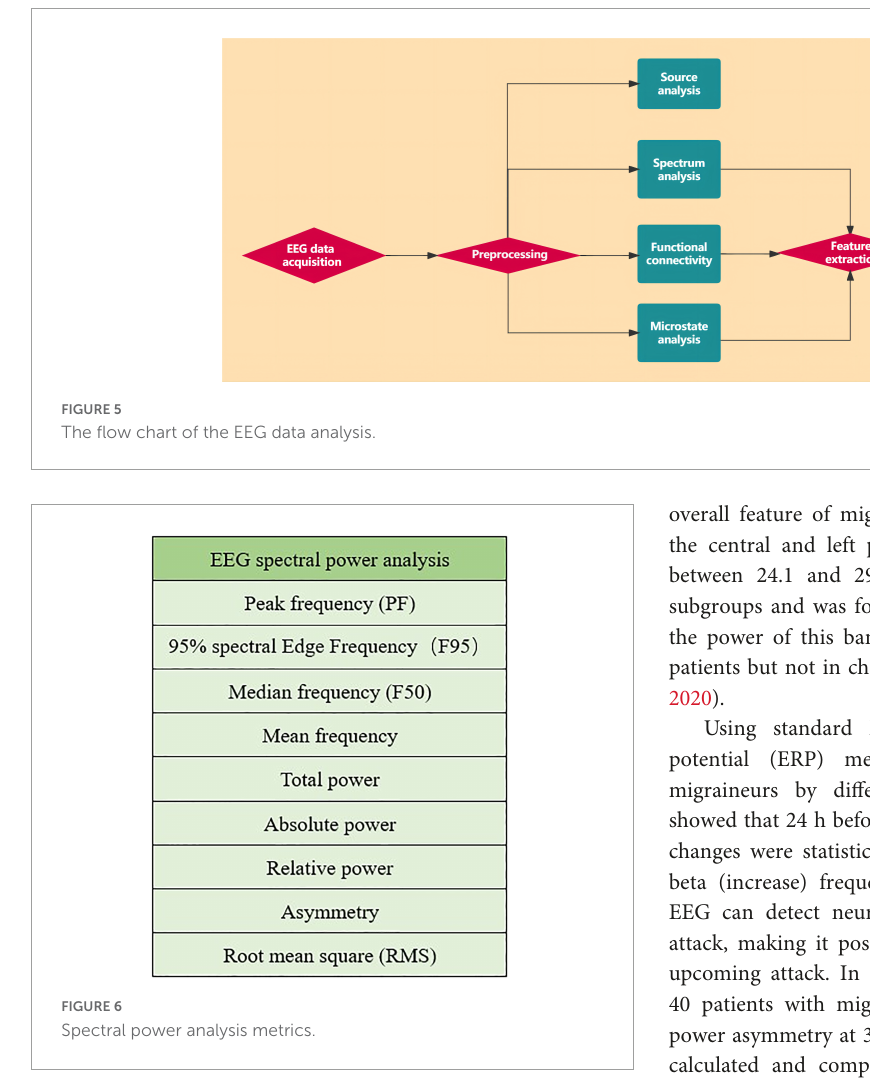
frequency bands were identified to distinguish the control group and the migraine group, as well as the migraine subgroup. The results showed that the frequency from 11.6 to 12.8 Hz was